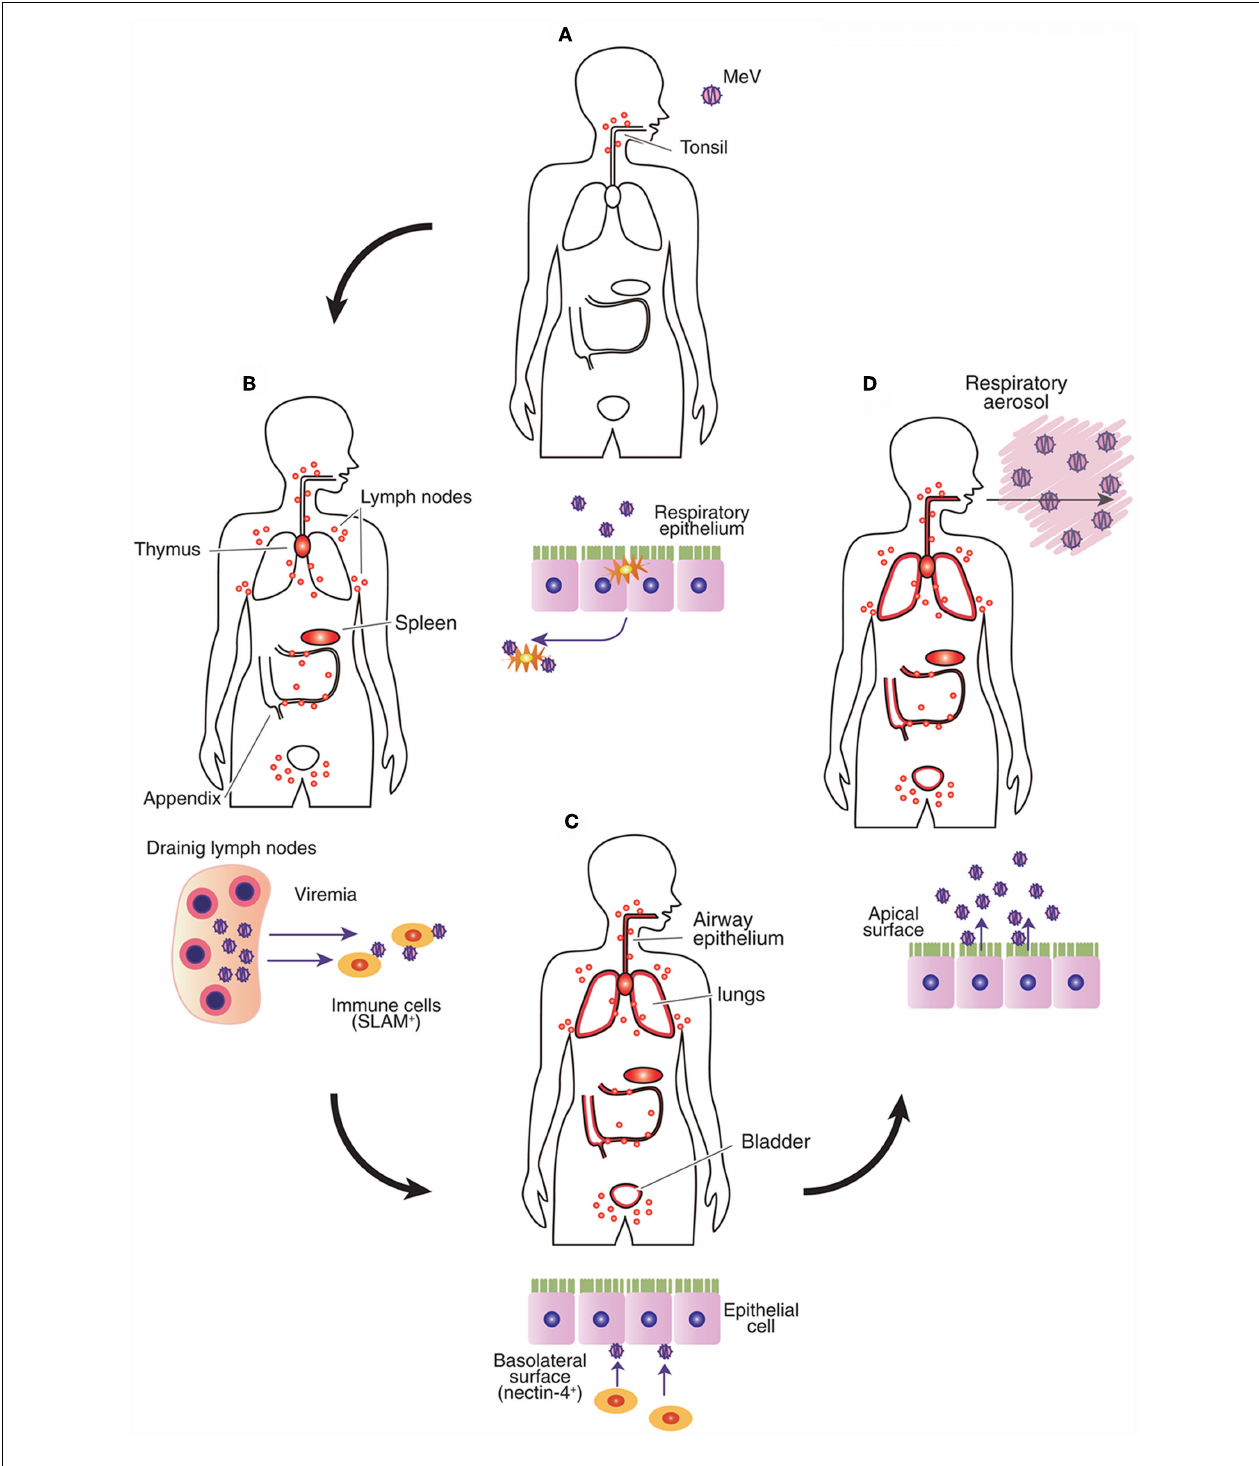
cell-associated viremia that distributes the infection to other organs. (C) MeV-infected immune cells transmit MeV to epithelial cells in various organs such as the airway, lung, and bladder from the basolateral side. (D) Progeny viruses are released from the host as respiratory